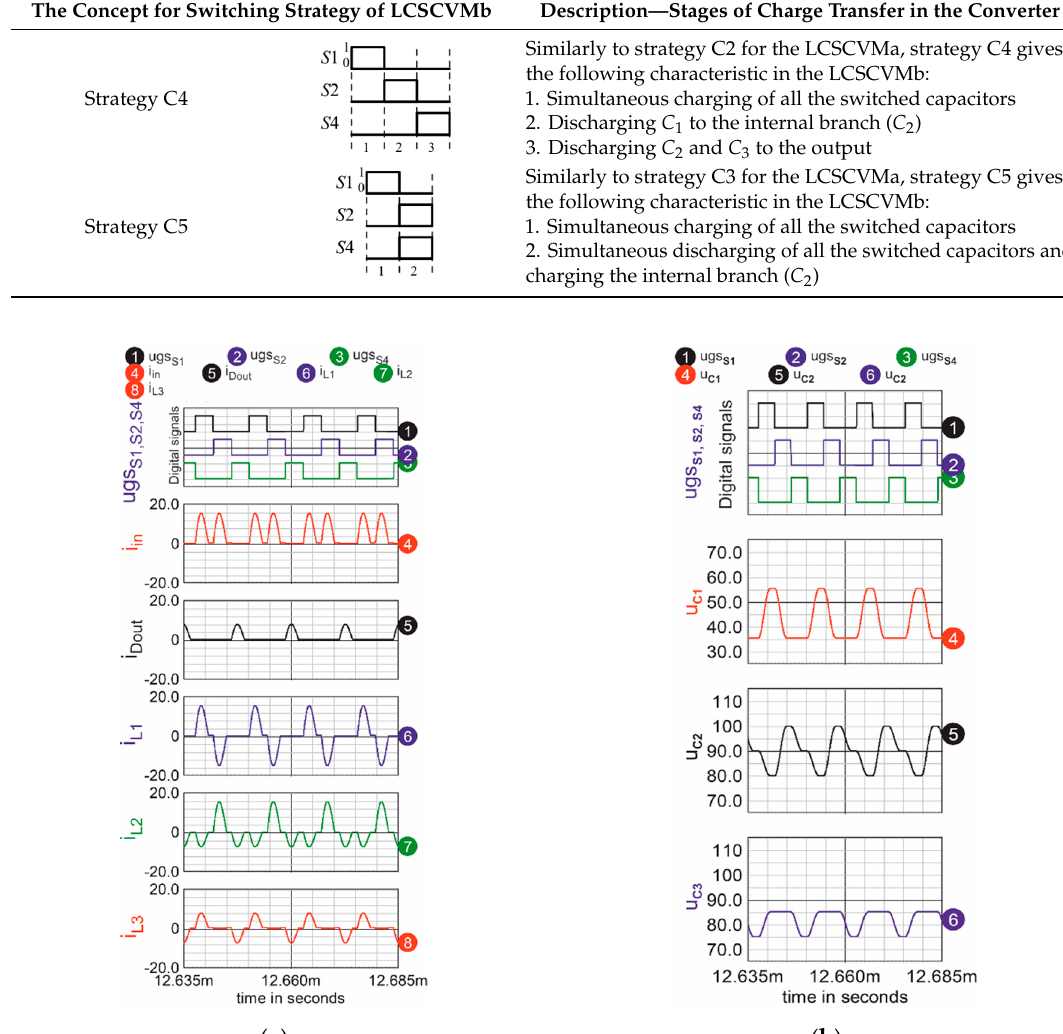
Figure 6. Steady-state operation of the LCSCVMb converter under switching strategy C4: ( a ) Waveforms of the input current, inductor currents, and the current of the output diode (in amperes). ( b ) Voltages (in volts) on capacitors C 1 , C 2 , and C 3 . The results were obtained with the use of ICAP/4 simulation software.